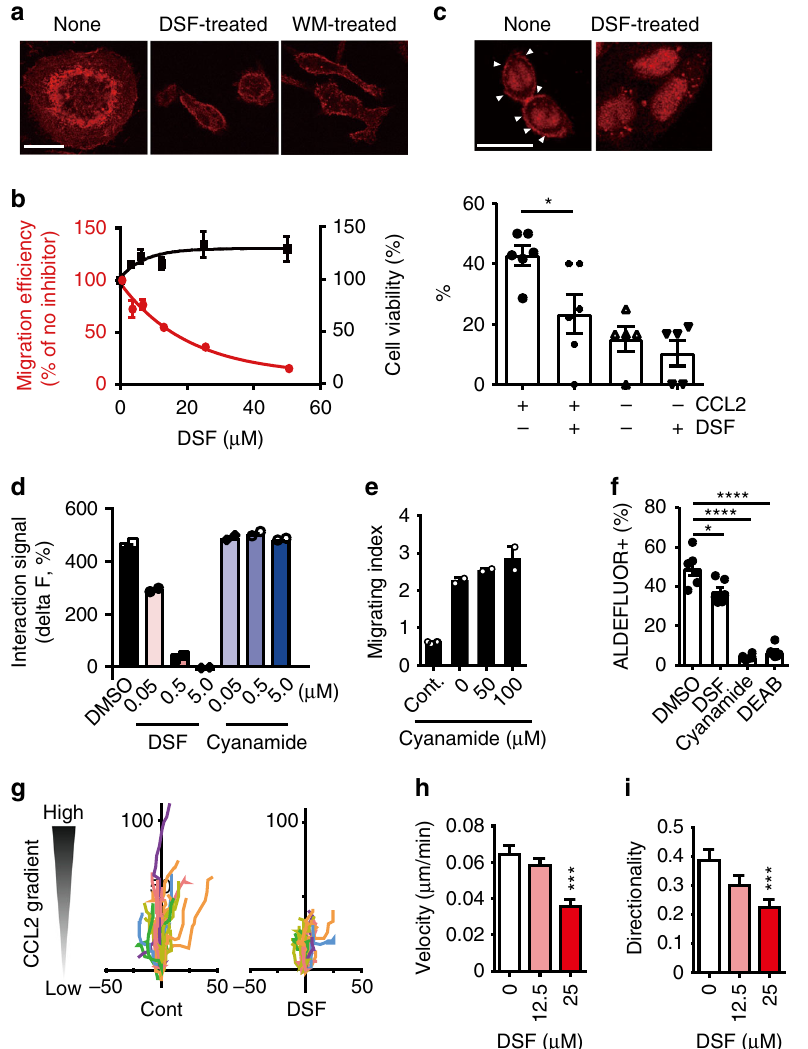
Fig. 6 Disul fi ram (DSF) is a potent inhibitor of chemokine-mediated FROUNT functions. a Effect of DSF (25 µ M) on CCL2-induced pseudopodia protrusion compared with DMSO control and wortmannin (WM, 25 µ M). b Effect of DSF on chemotaxis (red line), and cell viability (black line) (mean ± s.e.m., n = 3). c Translocation of PH-Akt-tHcRed to the plasma membrane as an indicator of PI3K activation in CCR2 + Chinese hamster ovary cells expressing PH-Akt-tHcRed, in the presence or absence of DSF upon stimulation with CCL2. Representative confocal microscopic images of cells stimulated with CCL2 (left) and percentage of cells in which PH-Akt-tHcRed was translocated to the membrane. Arrowheads indicate sites of membrane translocation of PH-Akt-tHcRed. More than fi ve visual fi elds were averaged. d, e The ALDH inhibitor cyanamide did not block FROUNT-CCR2 interactions or chemotaxis (mean ± s.e.m., duplicates from one of three independent experiments.). f ALDH inhibition activity of DSF and cyanamide evaluated by ALDEFLUOR assay (mean ± s.e.m., n = 6). g – i TAXIScan assay 57 for migration of THP-1 cells treated with DMSO (control) or DSF (50 μ M) towards CCL2. g cell tracks, h velocity, and i directionality. Plots indicate means of 28 cell tracks ± s.e.m. * P < 0.05, *** P < 0.001, **** P < 0.0001 by two-tailed unpaired Student ’ s t -test as compared to control. Scale bars, 20 μ